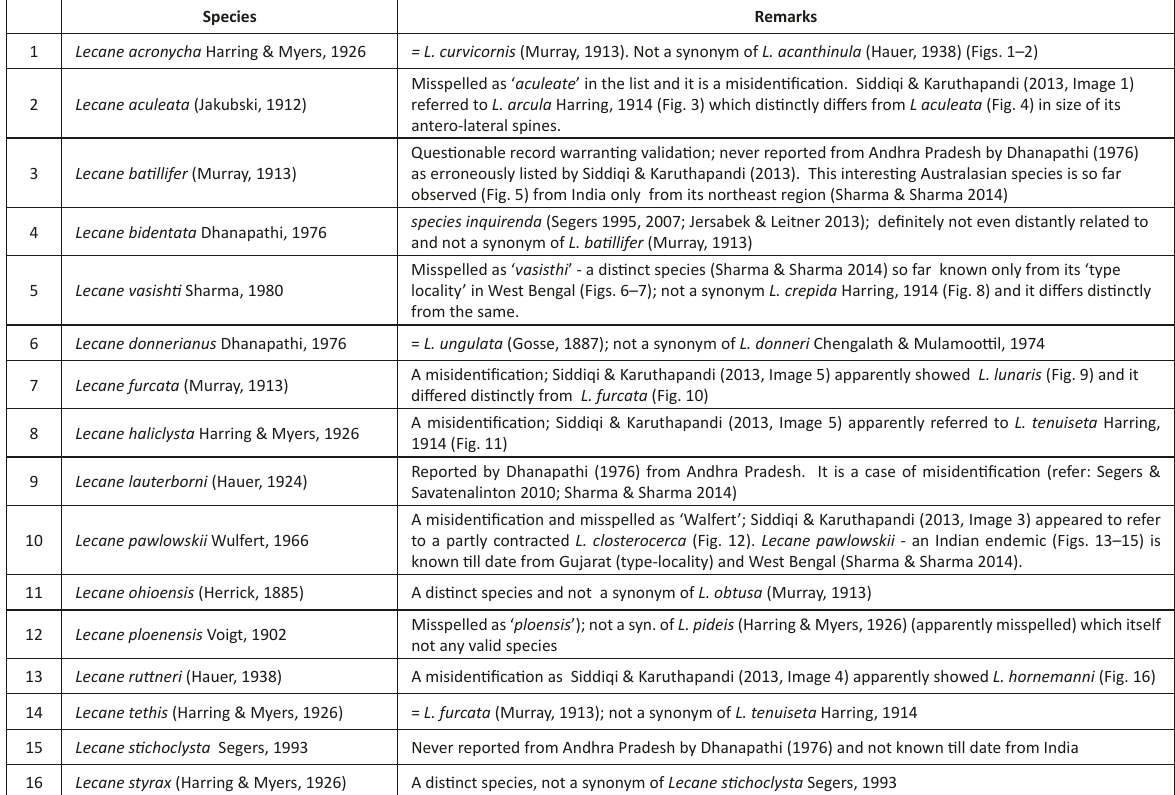
Table 1. Remarks on misidentifications and taxonomic status